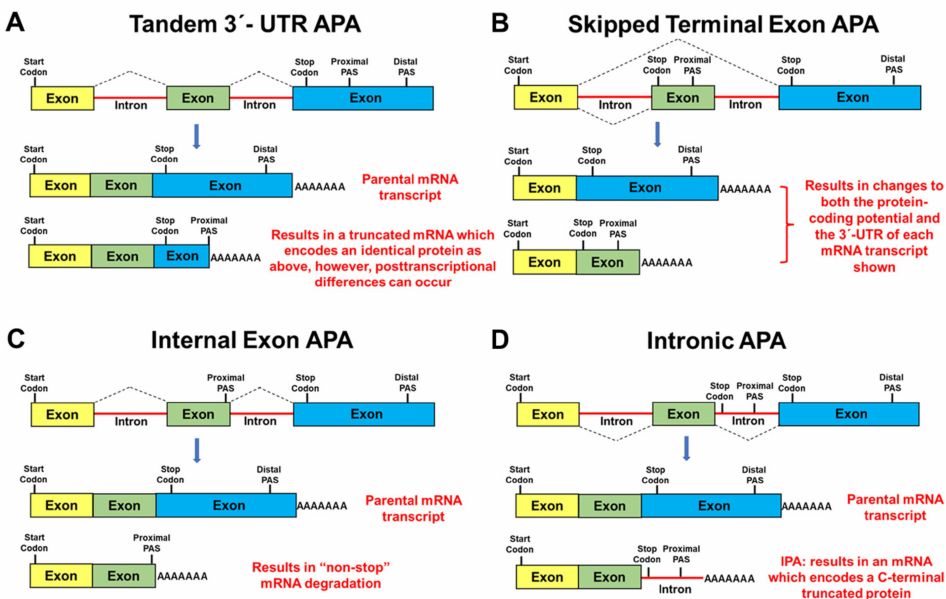
Figure 4. Schematic representation of mechanisms of alternative polyadenylation (APA). The figure displays different categories of alternative polyadenylation events [32–35]. ( A ) Tandem 3 (cid:48) -UTR APA; ( B ) Skipped Terminal Exon APA; ( C ) Internal Exon IPA; ( D ) Intronic APA. Further information regarding each class of alternative polyadenylation events is given in the